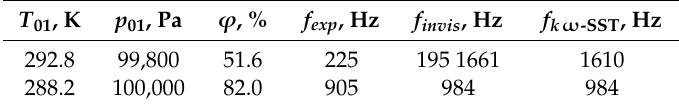
Figure 8. Oscillation frequency for parallel nozzle with air relative humidity equal to 51.6%, using inviscid (left) and k ω -SST (right) modelling. Table 1. Experimental ( f exp ) and numerical (inviscid f invis , viscous f k ω -SST ) frequency of oscillations for flow with relative humidity, ϕ , equal to 51.6% and 82%.